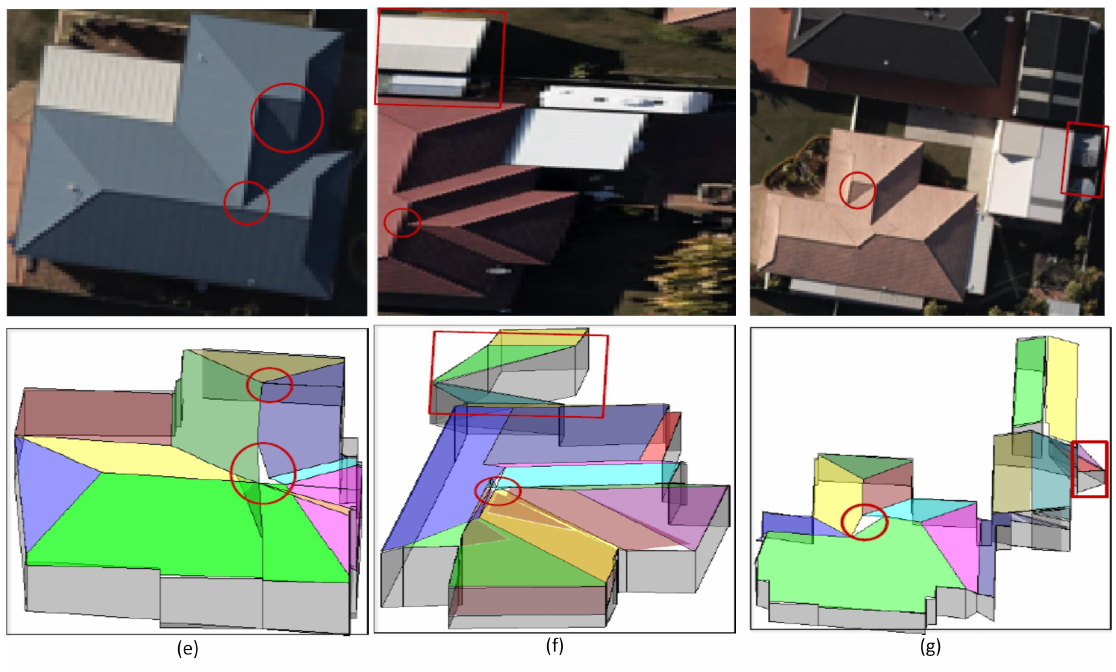
Figure 17. Issues in building modelling: The first row shows the building images and the second row illustrates the building models: ( e – g ) are indicated in Figure